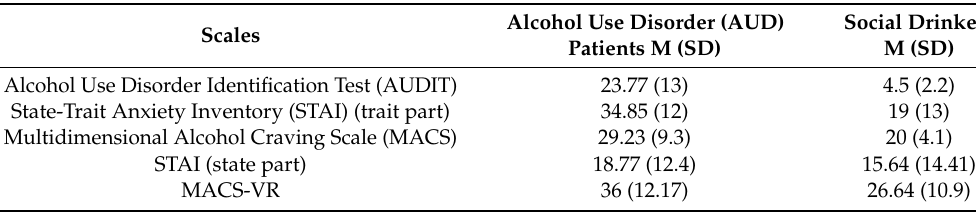
Table 1. Data of the self-reported